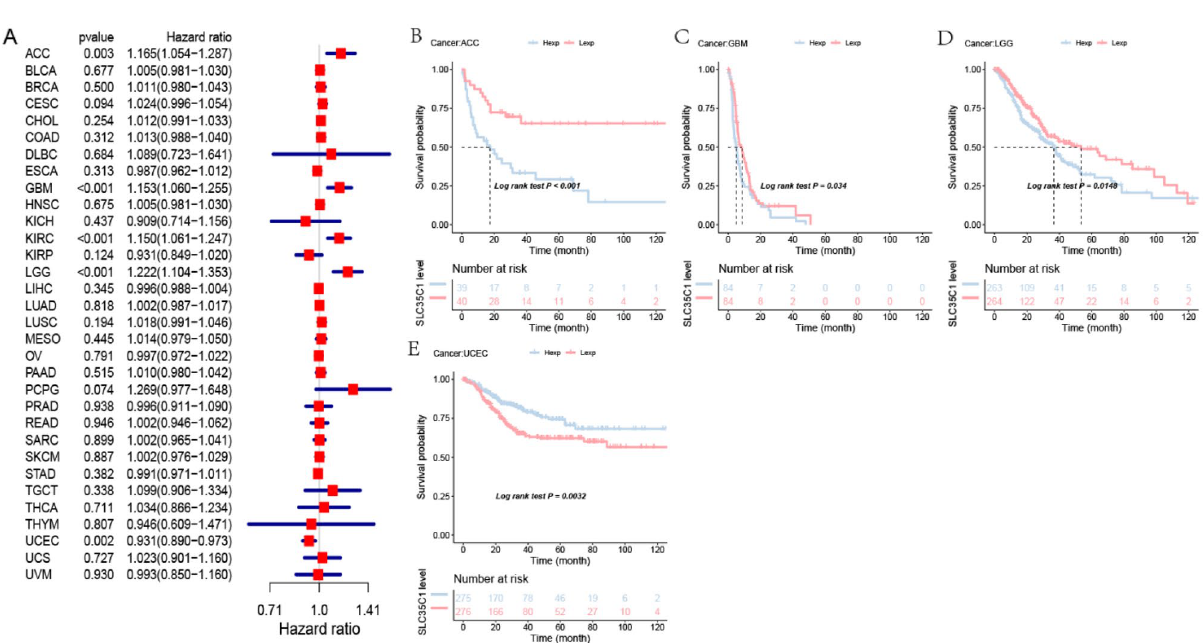
Figure 4. Association of SLC35C1 expression with patient progression-free interval (PFI) in pan- cancer. ( A ) Forest plot of HR for the relationship between SLC35C1 expression and patient PFI. ( B – E ) Kaplan–Meier analyses show the association between SLC35C1 expression and PFI. Statistical significance was assessed using the log-rank